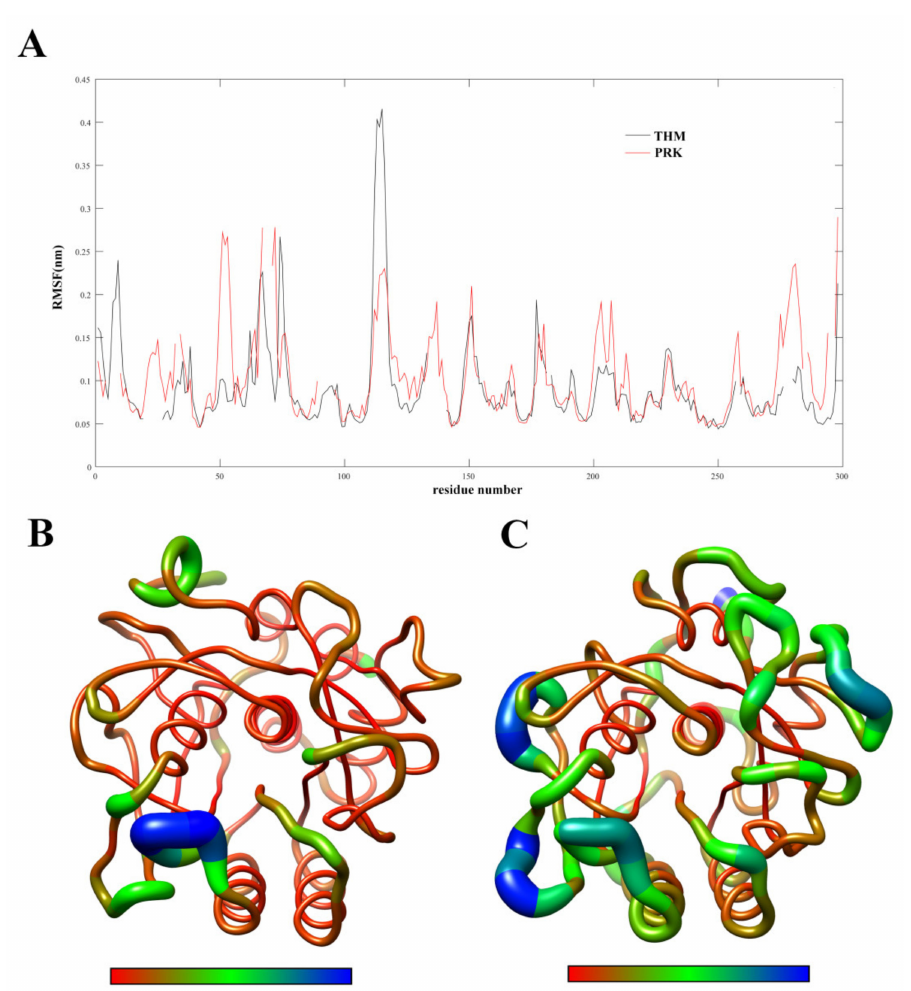
Figure 3. Comparison between the structural flexibility of THM and PRK. ( A ) Per-residue average backbone RMSF profiles calculated from MD trajectories of THM (black line) and PRK (red line). The gap of the curves corresponds to the insertion or deletion in the structural alignment. The residues are numbered according to the PRK structure. ( B , C ) are 3D backbone representations of the THM and PRK structures mapped with per-residue average backbone RMSF values, respectively. The backbone color ranges from red to blue and corresponds to a line from thin to thick and denotes that the backbone RMSF varies from the lowest to the highest values. ( B , C ) were generated using UCSF Chimera